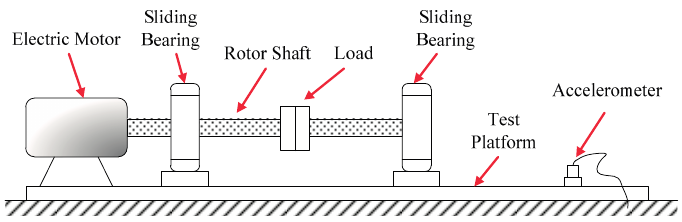
Figure 6. Sliding-bearing experimental table for shaft-bending fault